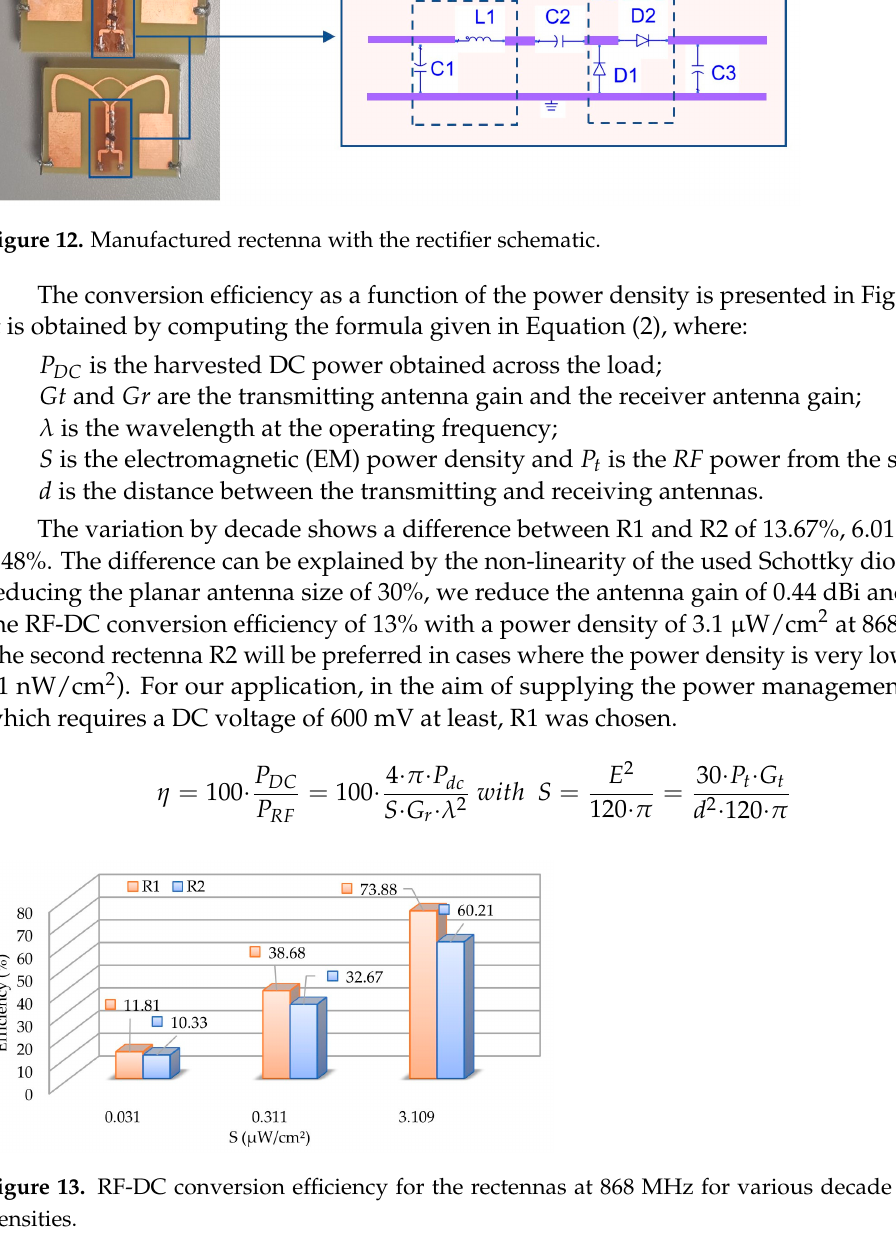
Figure 13. RF-DC conversion efficiency for the rectennas at 868 MHz for various decade power densities.